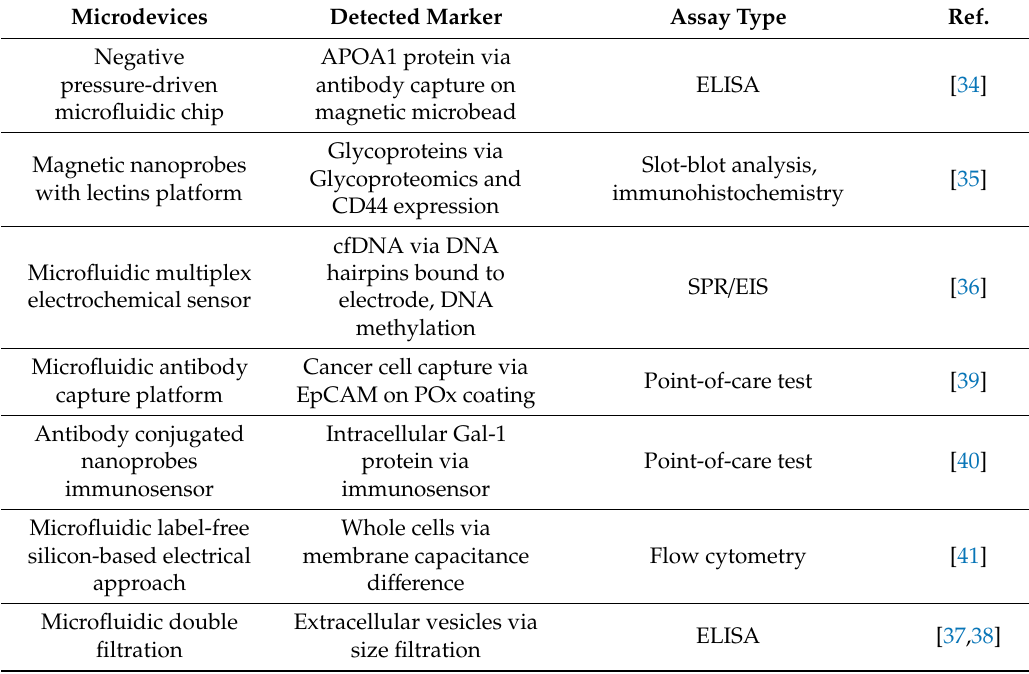
Table 2. Types of microdevices for bladder cancer detection in